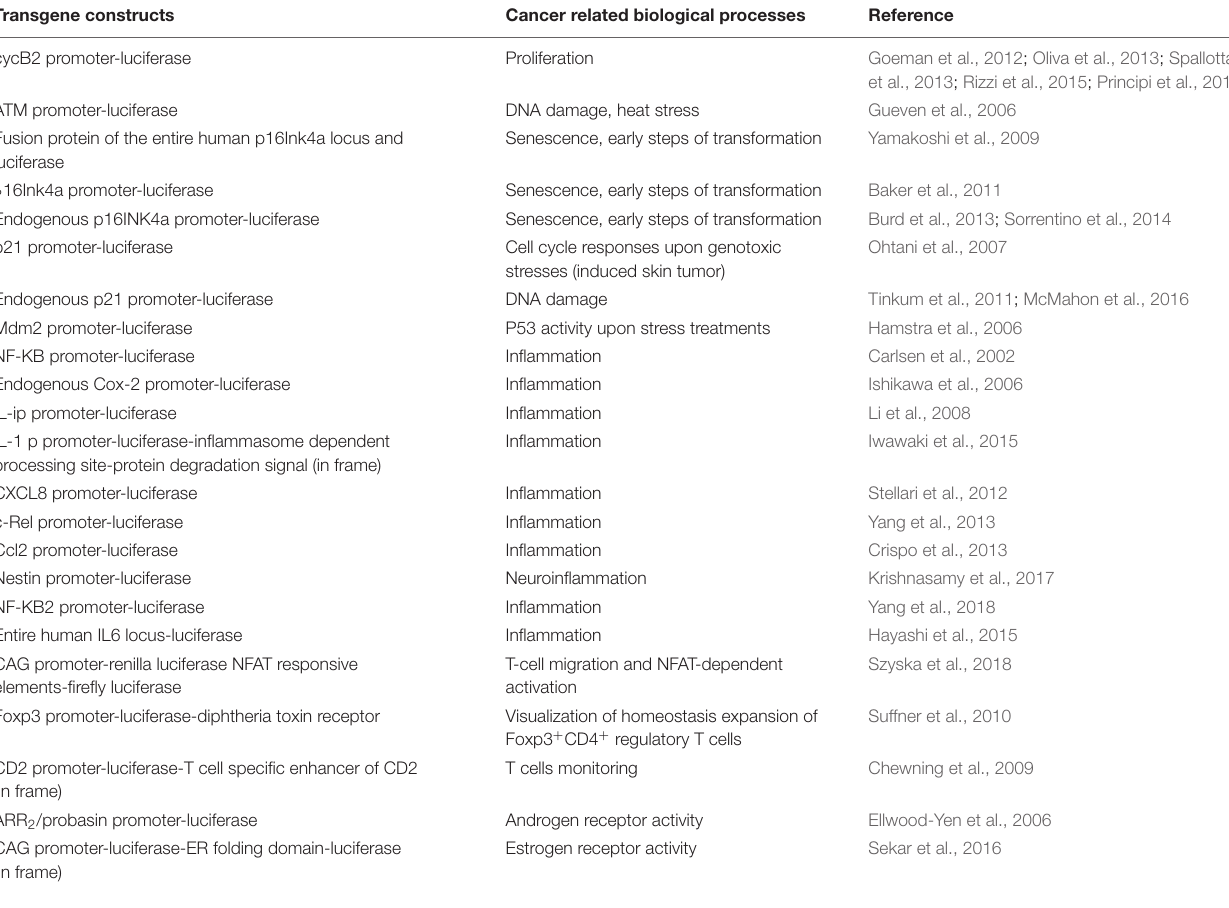
TABLE 1 | List of genetically engineered mouse models useful to illuminate cancer-related processes. Transgene